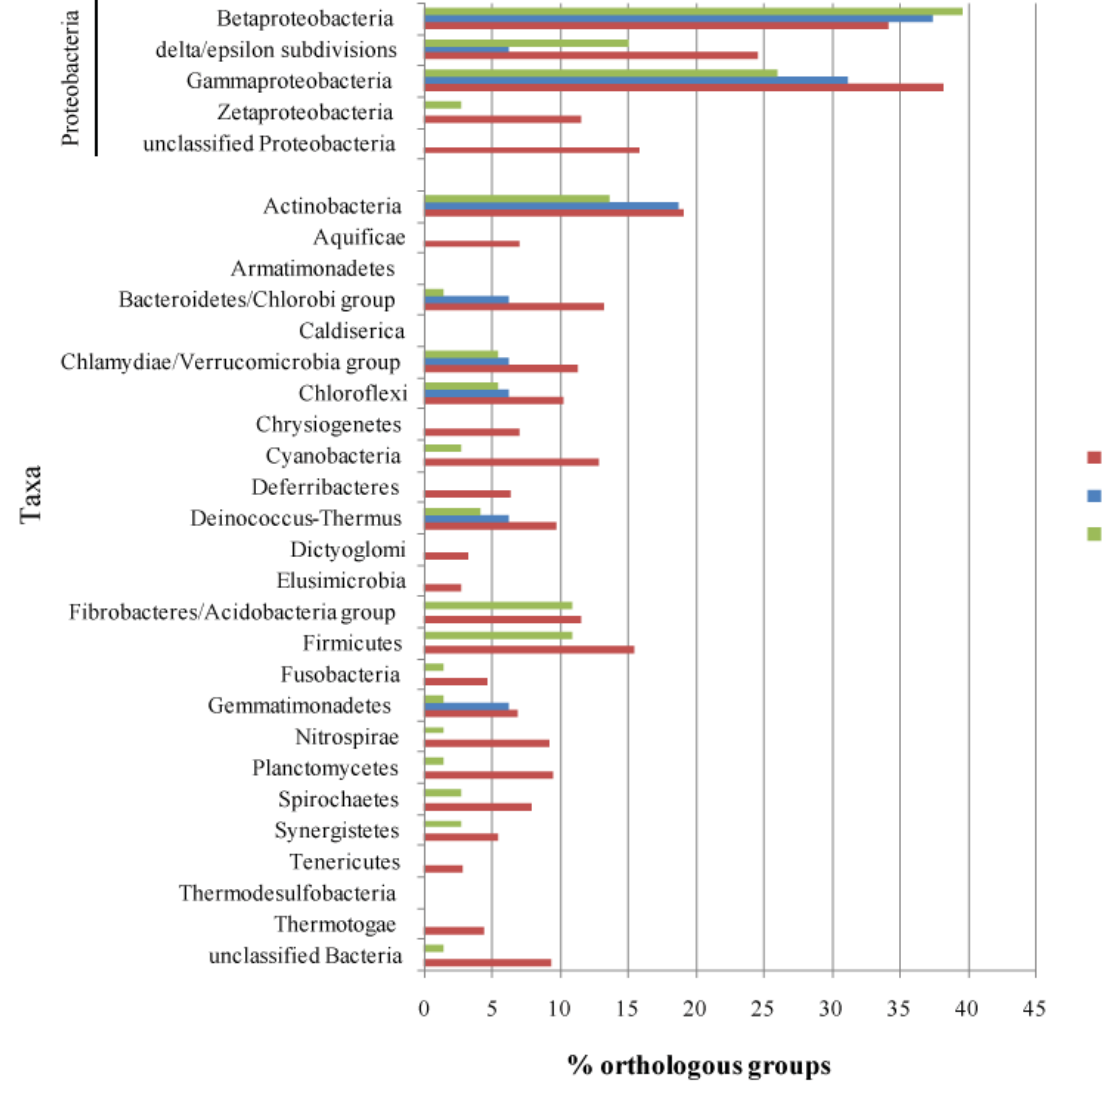
Figure 5. Taxonomic sharing of life-style associated genes. For each taxonomic division (according to NCBI), the proportion of the life-style related orthologous groups having at least one significant hit is